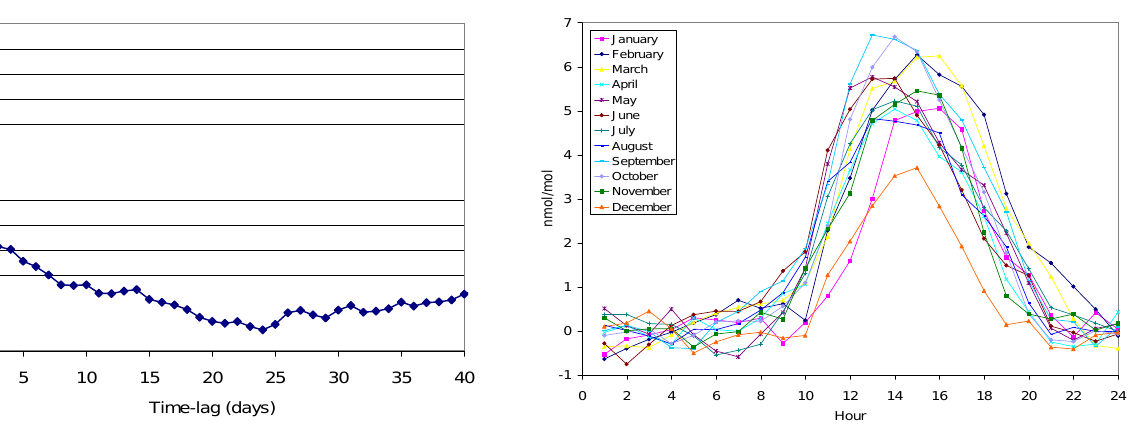
Fig. 8. Carbon monoxide mean diurnal cycle relative to the noctur- nal background